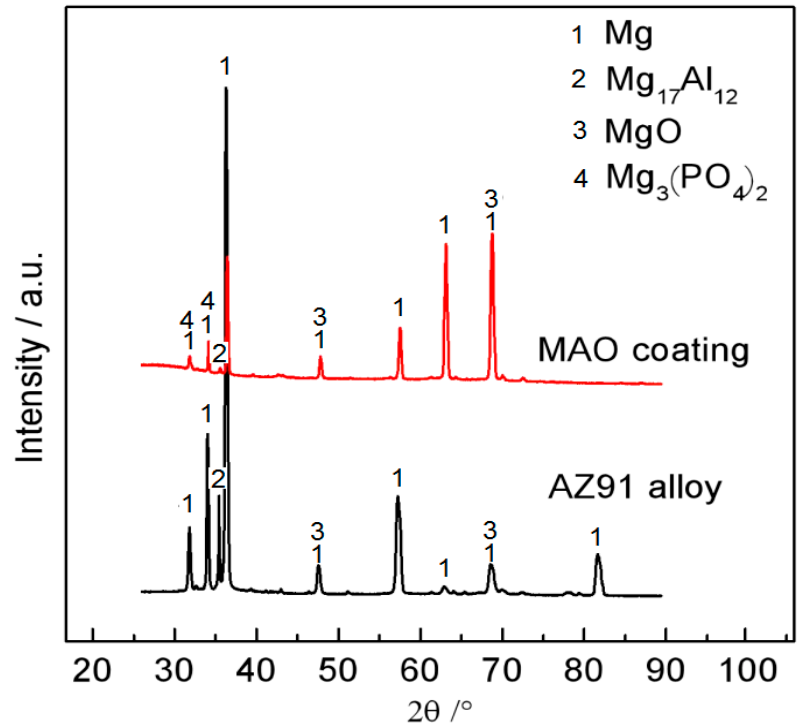
Figure 2. XRD patterns of the alloy and the coating.